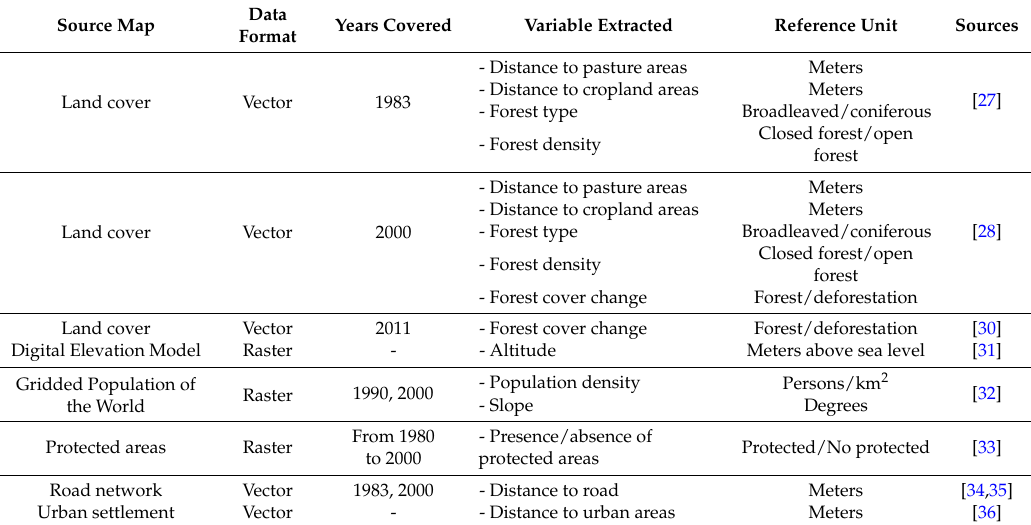
Table 1. List of variables used to calibrate and validate the